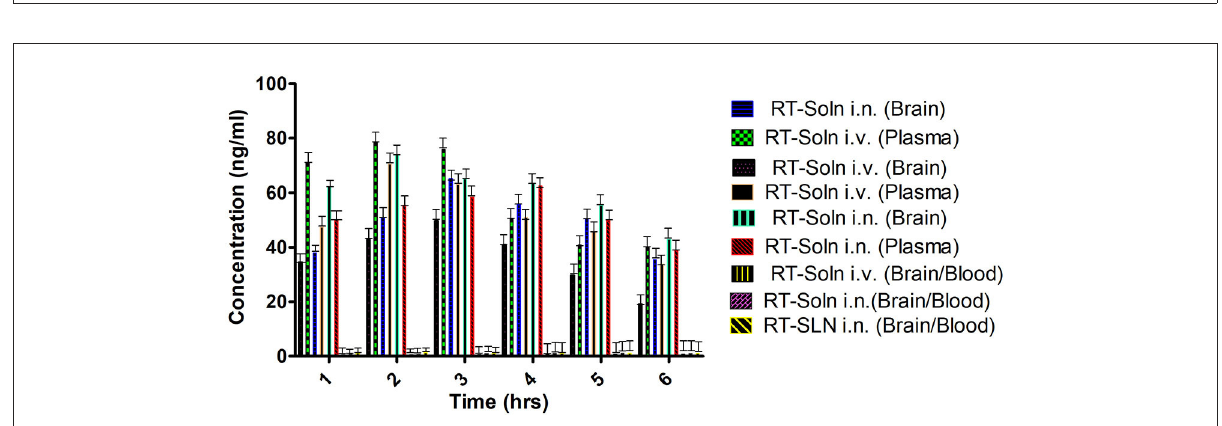
FIGURE11 Illustration of compartmental distribution of RT-SLN (i.n.) and RT solution after i.n. and i.v. administration.